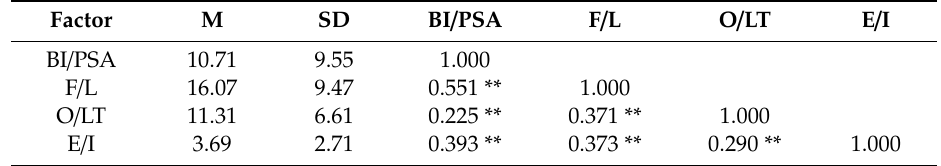
Table 2. Means, standard deviations, and correlation coe ffi cients of the factors that make up the barriers to the practice of physical exercise.